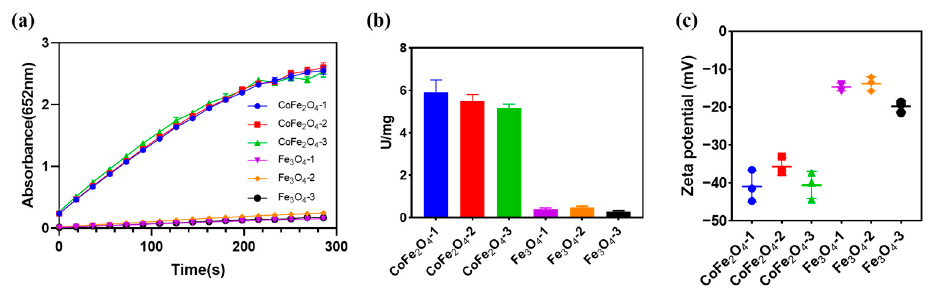
Figure 4. Comparison of peroxidase-like activity and surface charge between CoFe 2 O 4 nanozymes and Fe 3 O 4 nanozymes. ( a ) Time curve of TMB reaction catalyzed by nanozymes. ( b ) Comparison of POD-speci fi c activity among CoFe 2 O 4 nanozymes and Fe 3 O 4 nanozymes. ( c ) Zeta potential measurements indicating good dispersity of CoFe 2 O 4 nanozymes.